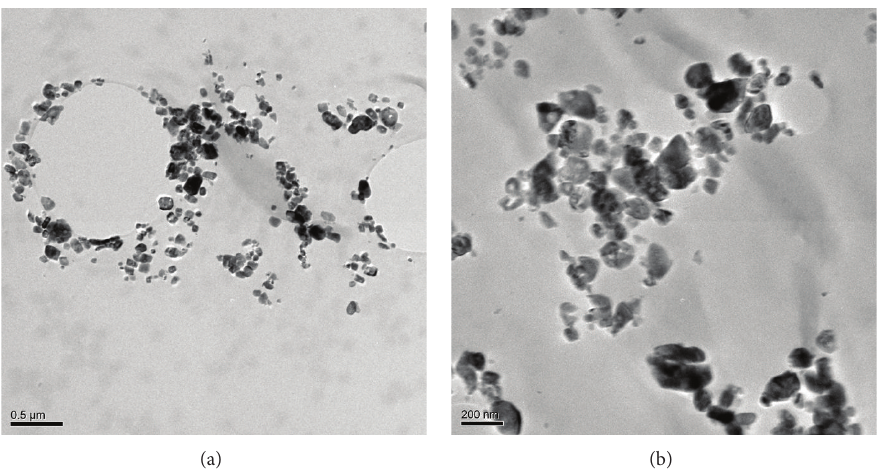
Figure 3: TEM images of CP 1 taken at low (a) and high (b) magnifications.